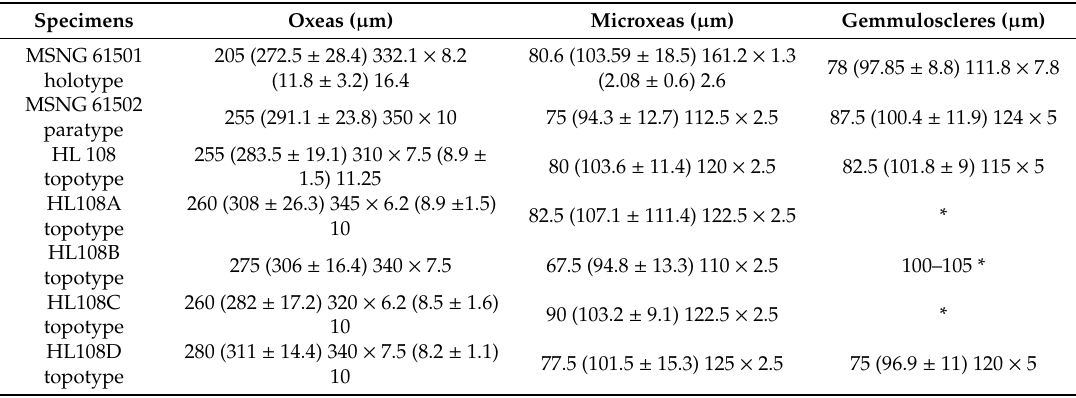
Figure 3. Spongilla manconiae sp. nov. ( a ) Paratype MSNG 61502 grown under a piece of polystyrene floating in the lake; ( b ) Magnification of the gemmules; ( c ) SEM image of the gemmules; ( d ) Gemmule with a single foramen; ( e ) Section of a gemmule, with a simple, monolayered theca, armored by a layer of tangential gemmuloscleres; ( f ) Histological section of a gemmule. Table 2. Spicule dimensions of the examined specimens. The “*” indicates the absence or scarcity of spicules in the preparation due to the lack of